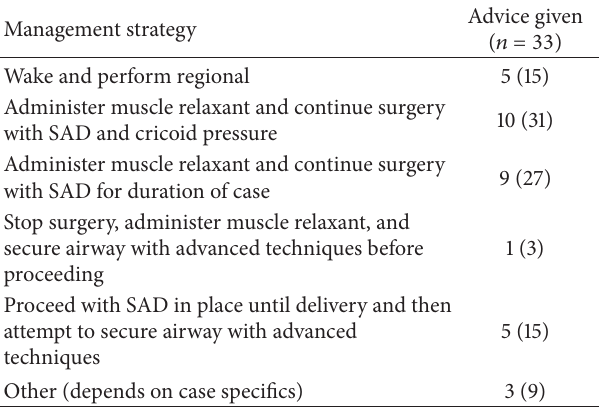
Table 4: Management strategies that anaesthetists would utilise if faced with failed intubation for category 1 caesarean delivery scenario (for anaesthetists that would consider continuing surgery).